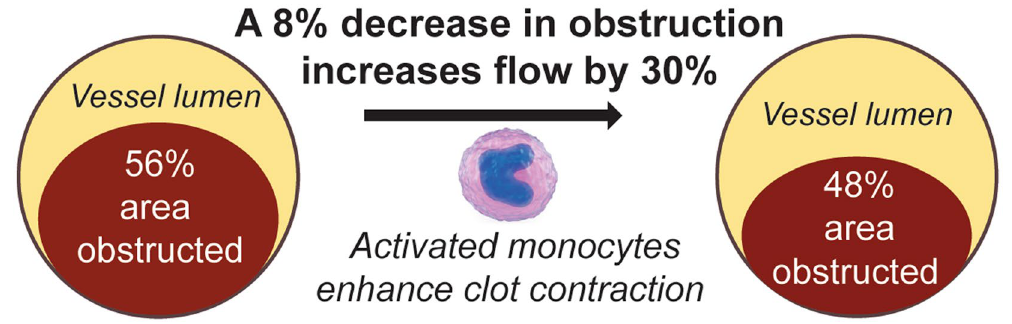
Figure 4. Relationship between the degree of vessel obstruction and blood flow. Thrombotic vessel obstruction increases the vascular resistance as described by Poiseuille’s law, which says that resistance is inversely related to the radius to the fourth power. Therefore, if the radius (or diameter) of a vascular segment is reduced by one-half, the resistance or the volumetric blood flow within that narrowed segment increases by 16-fold, which is a dramatic effect relative to the change in degree of vessel obstruction. Based on the Poiseuille’s equation: Volume flow rate = π * ( pressure difference ) * ( radius ) 4/8 * ( viscosity ) * ( length ) the change in the cross-sectional area corresponding to a decrease of the degree of vessel obstruction from 56% to 48% will result in an increase in the volumetric blood flow by about